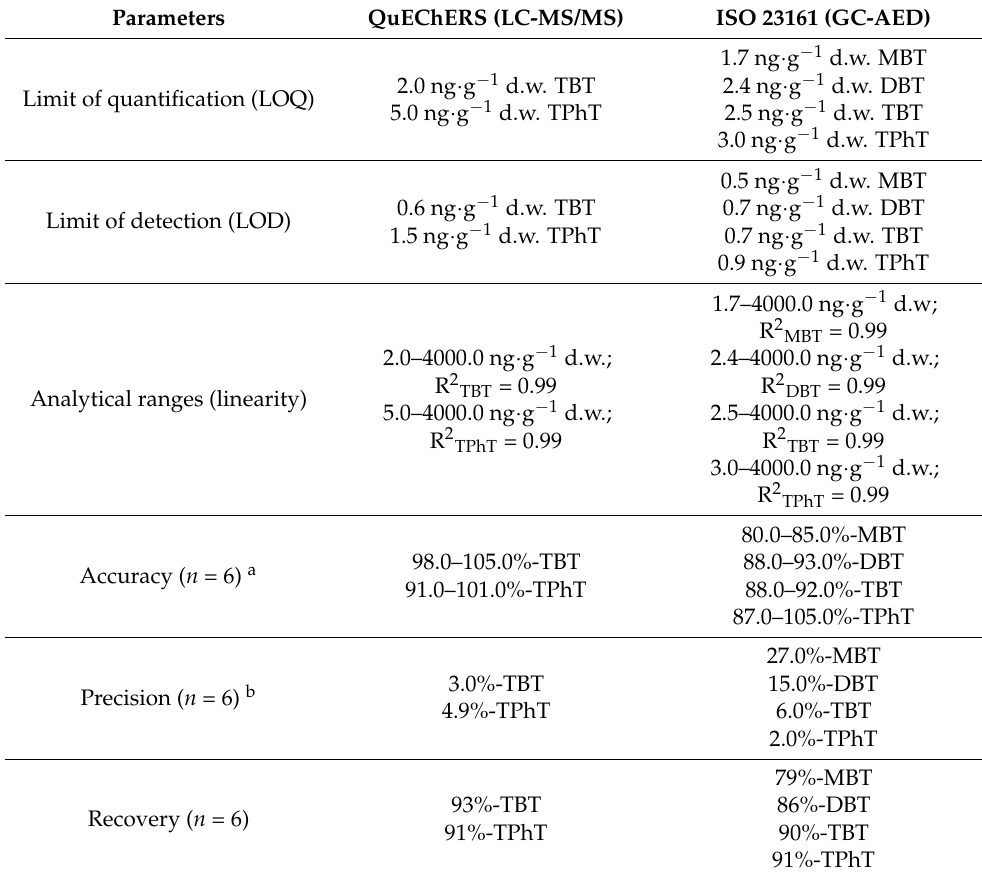
Table 1. Validation parameters of QuEChERS LC-MS/MS and ISO 23161 GC-AED methods